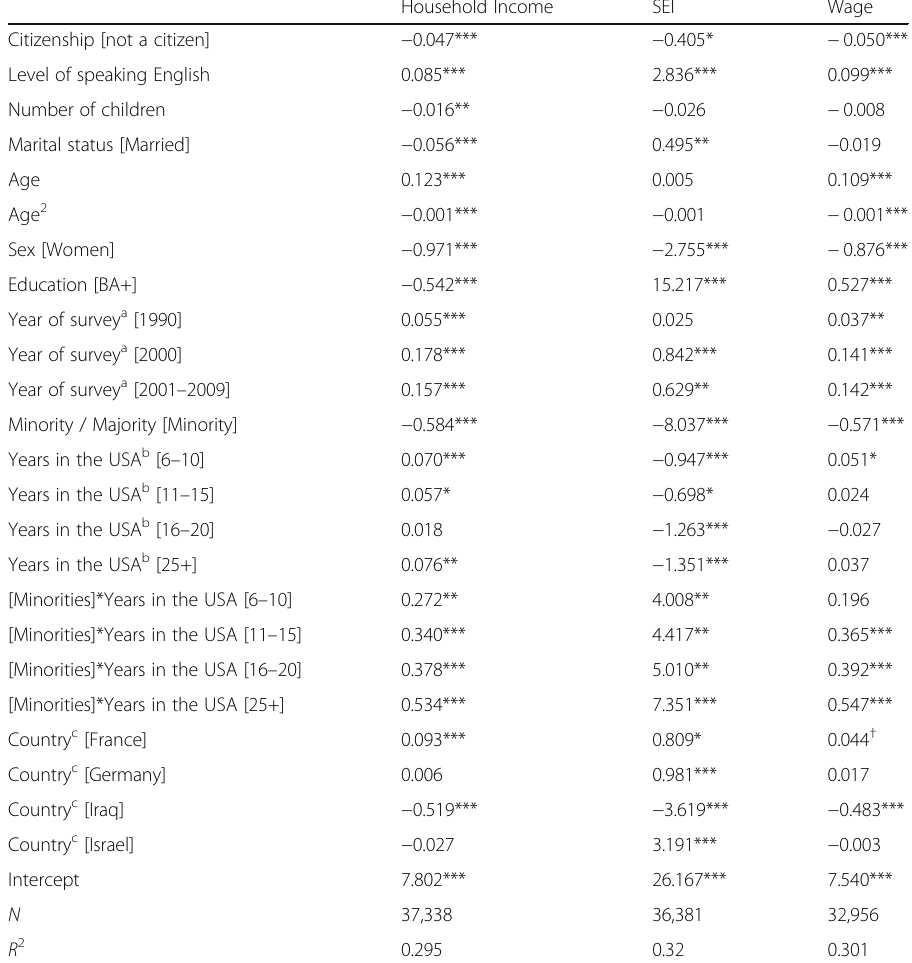
Table 7 Full regressions of economic characteristics for immigrants to the USA, age 25 to 64, interaction of ethnicity with years in the